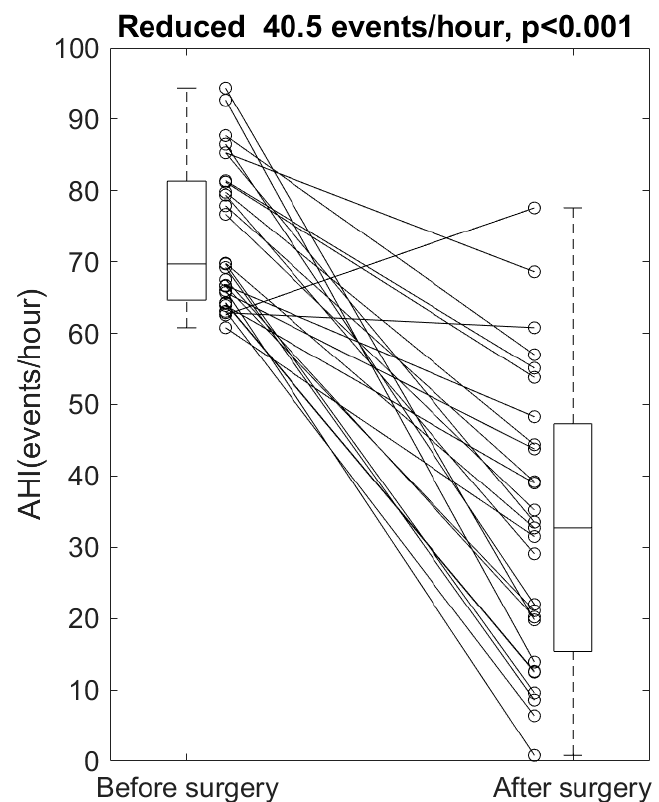
Figure 1. Individual apnea–hypopnea index (AHI) changes revealed a significant reduction after the surgery. Each boxplot displays a five-number summary: the minimum, the maximum, the median, and the first and third